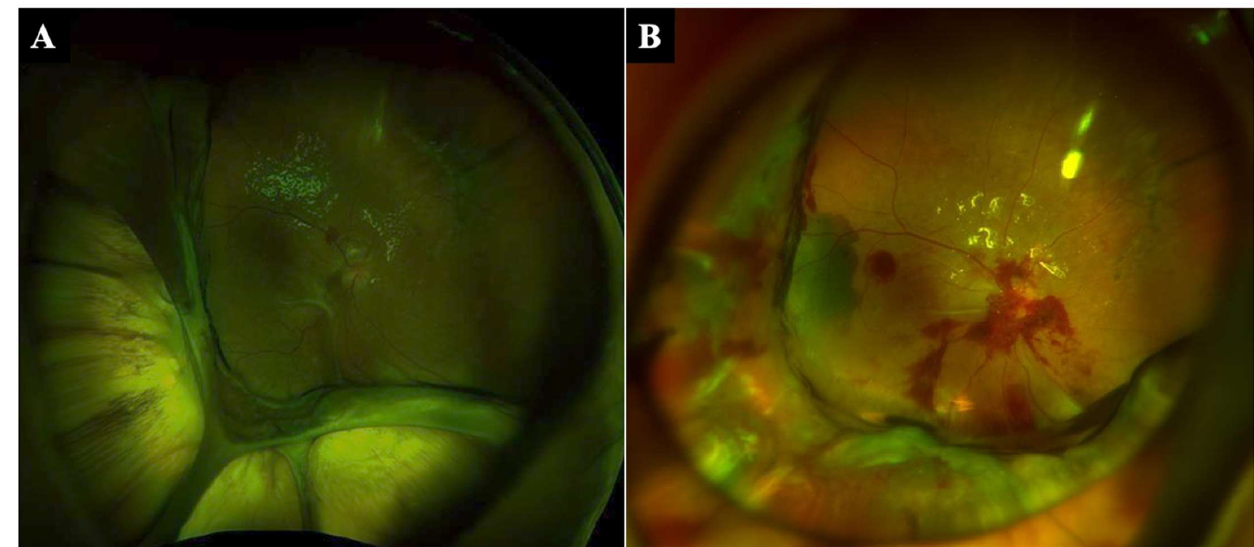
Figure 2. Fundus photographs before and after the 7-0 nylon single suture technique. A 55-year-old woman underwent scleral suturing and vitrectomy for globe rupture, and it was found that the choroid-ciliary body was avulsed at 360 degrees during surgery. The choroid was still detached from the sclera postoperatively, the retina-choroid gradually slid downward to the posterior pole together, and the exposed sclera widened with time ( A ). The avulsed choroid was sutured to the sclera, and the exposed sclera could be covered by the retina-choroid ( B ).